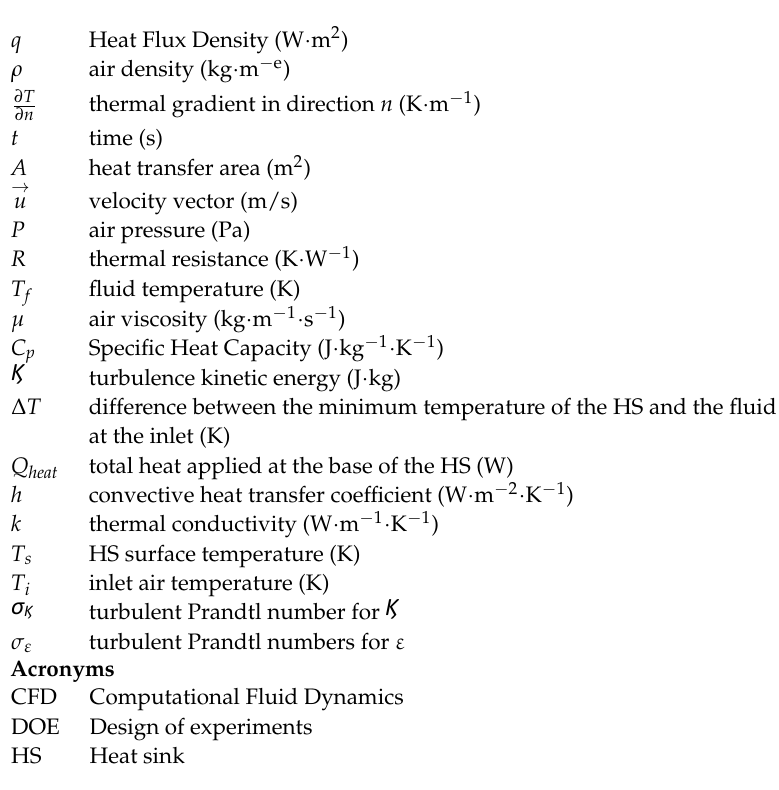
Figure 3. Temperature contours vs. time for each type of heat sink.